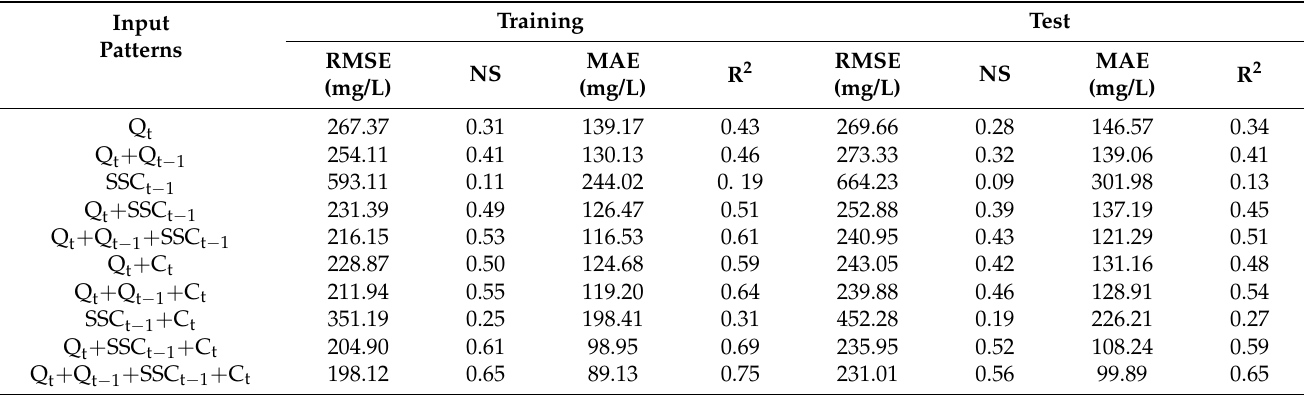
Table 8. Results of monthly SSC modeling by RBF with different input patterns during training and test